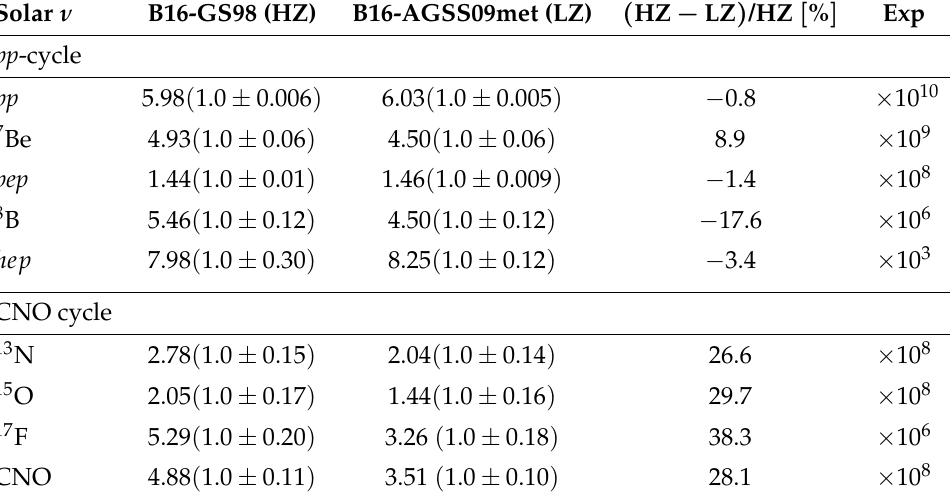
Table 3. Solar neutrino fluxes predicted by Standard Solar Models B16-GS98 (High Metallicity,